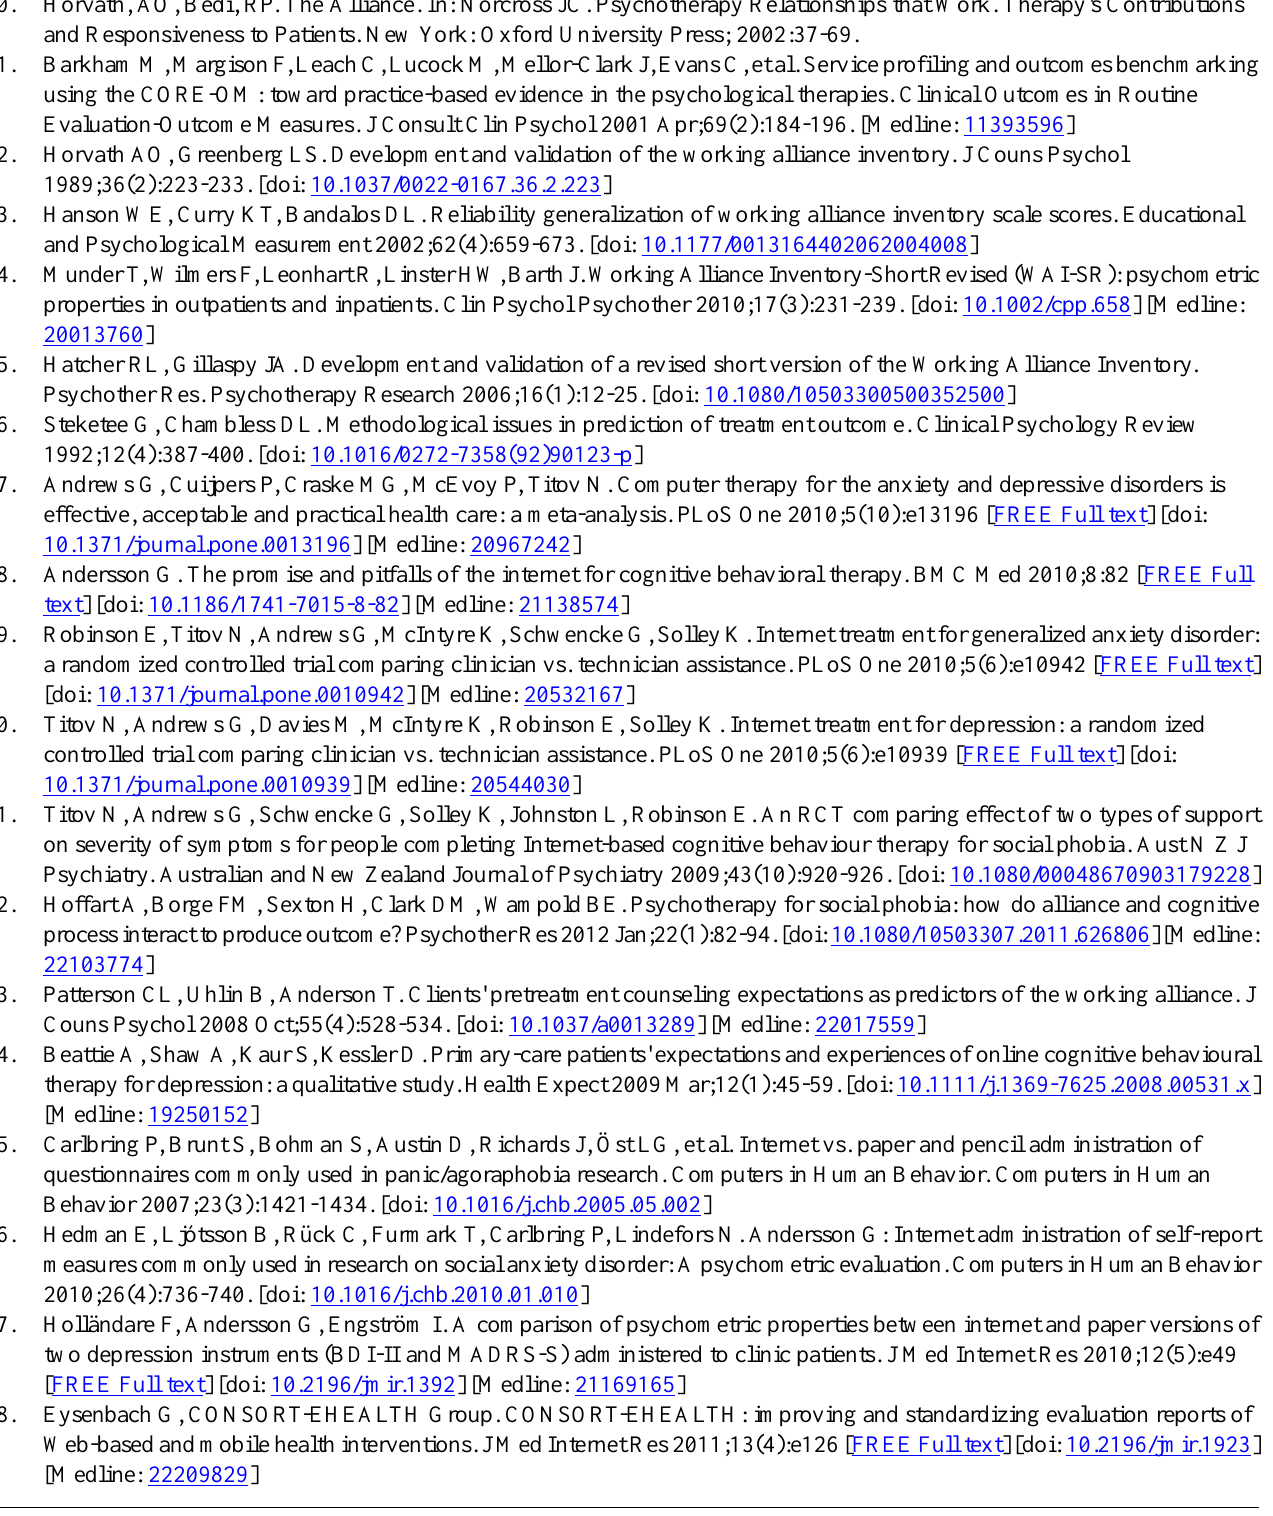
PTSD: post-traumatic stress disorder SAD: social anxiety disorder SCID-I: Structured Clinical Interview for DSM-IV Axis I